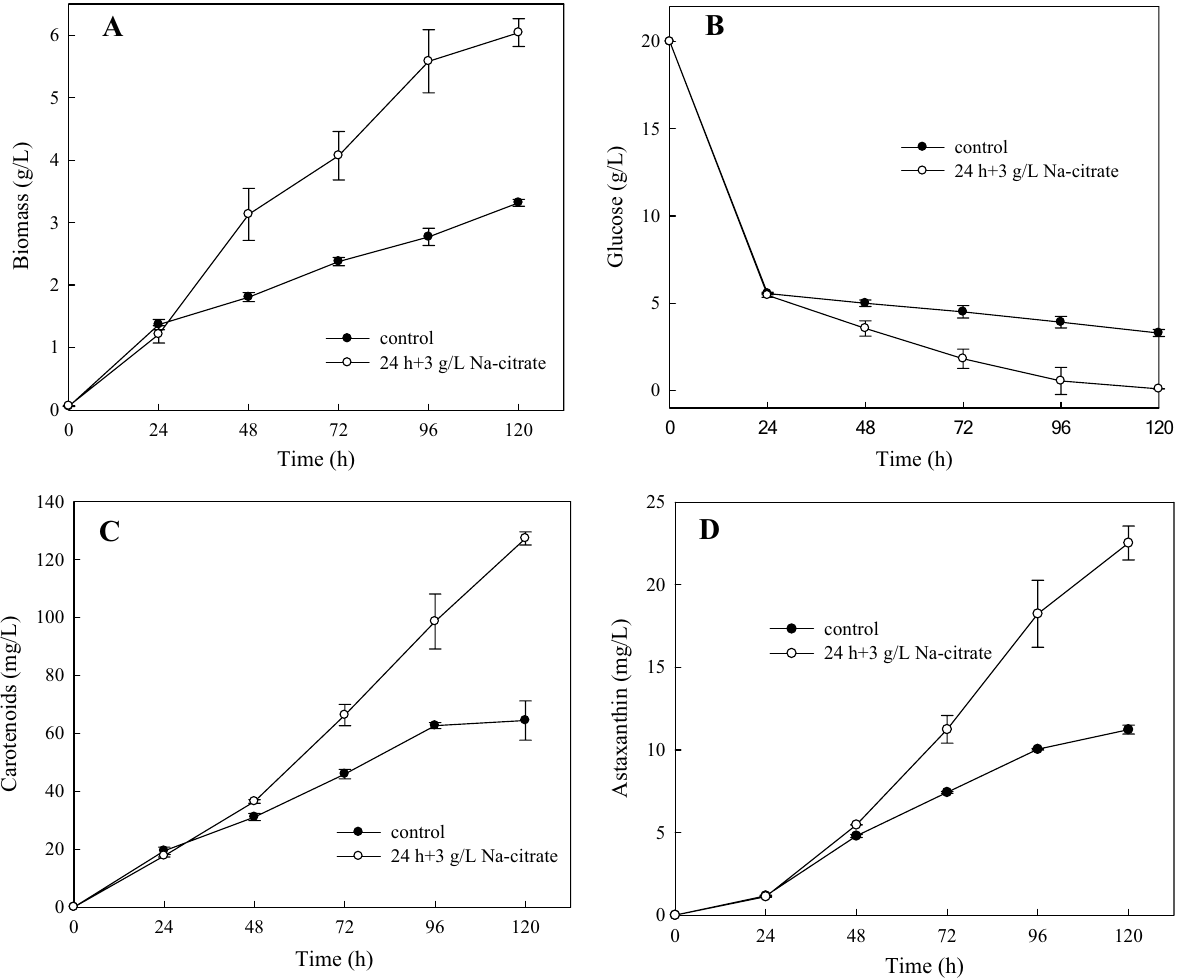
Fig. 1 Time-course profiles of X. dendrorhous cultures in the Na-citrate and control groups. Control group: solid circles, Na-citrate group: hollow circles. A Biomass (g/L); B glucose (g/L); C carotenoids (mg/L); D astaxanthin (mg/L). The cells were grown in a 250-mL Erlenmeyer flask containing 50 mL fermentation medium, with the temperature maintained at 22 °C and the stirring speed at 200 rpm. Values are means three independent